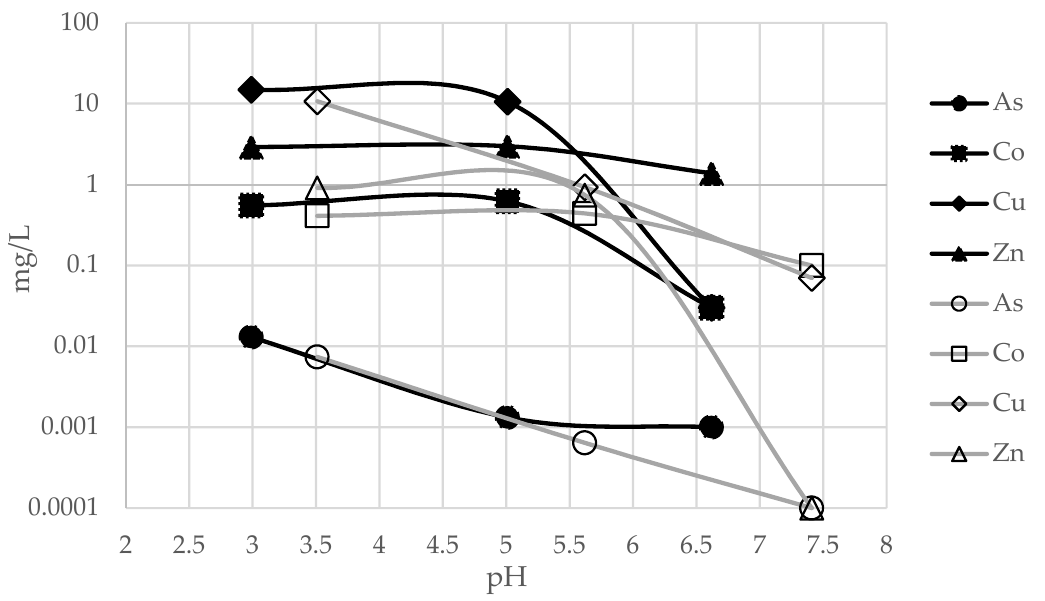
Figure 14. Comparison of some trace elements ion concentrations between FA3 (full symbols) and FA4 (empty symbols) from the beginning to the end of buffering.